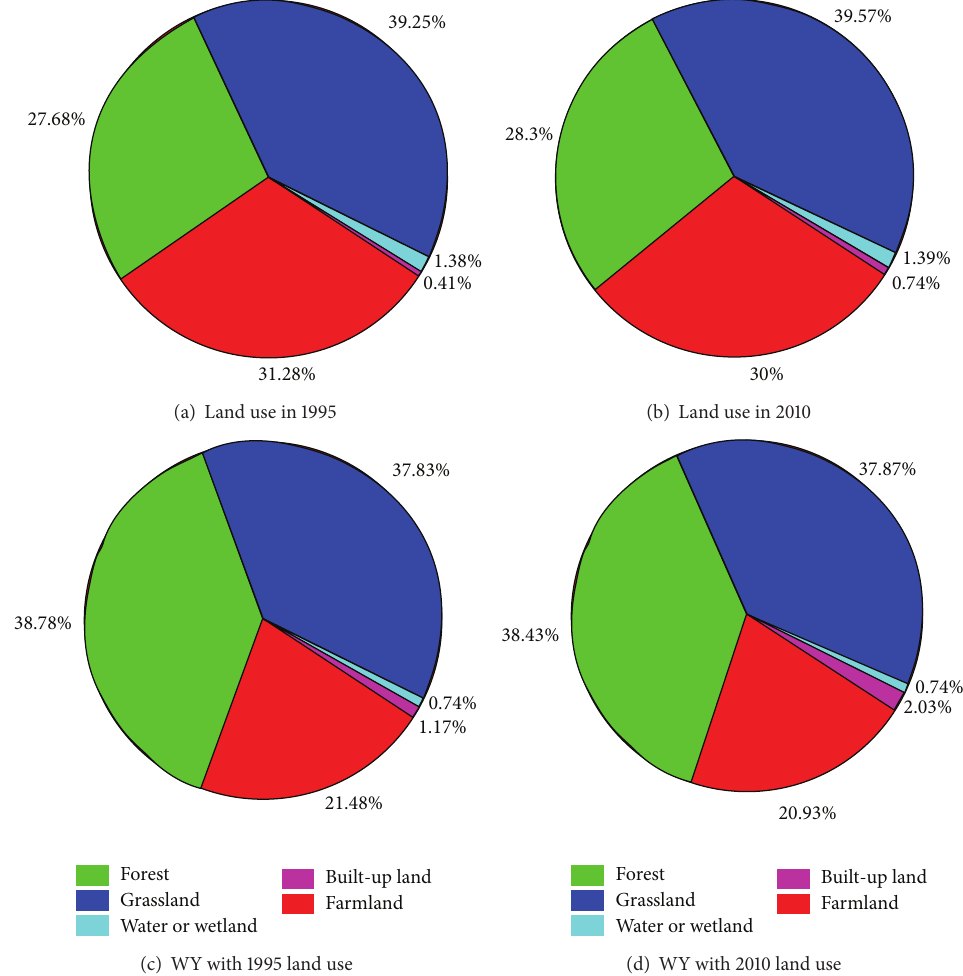
Figure 5: Percentage of each LULC change and its contribution to the total average annual water yields (WY) for the Upper Fenhe River watershed from 1992 to